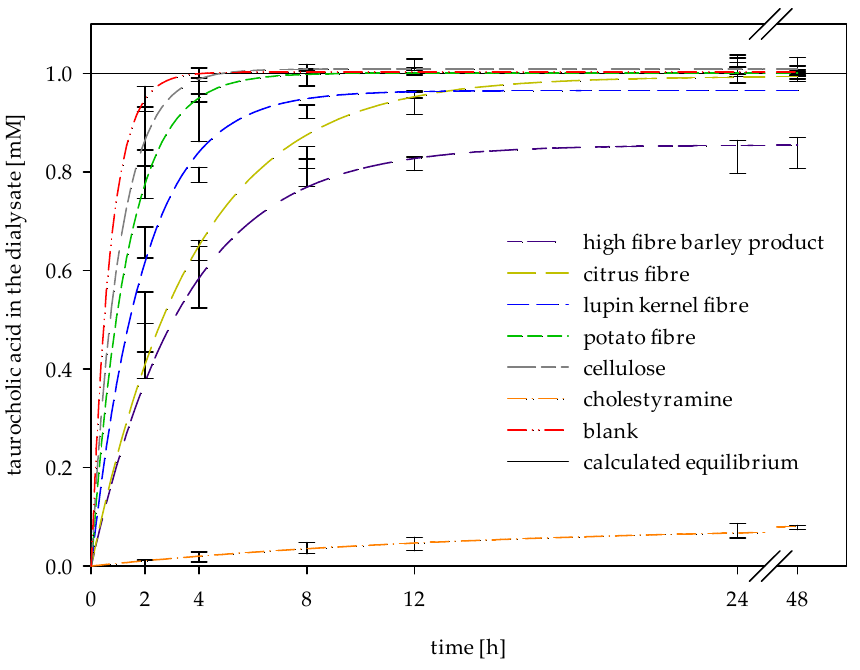
Figure 2. Diffusion kinetics of taurocholic acid release across a dialysis membrane without (blank) and with different dietary fibre-rich materials and references ( n = 3).